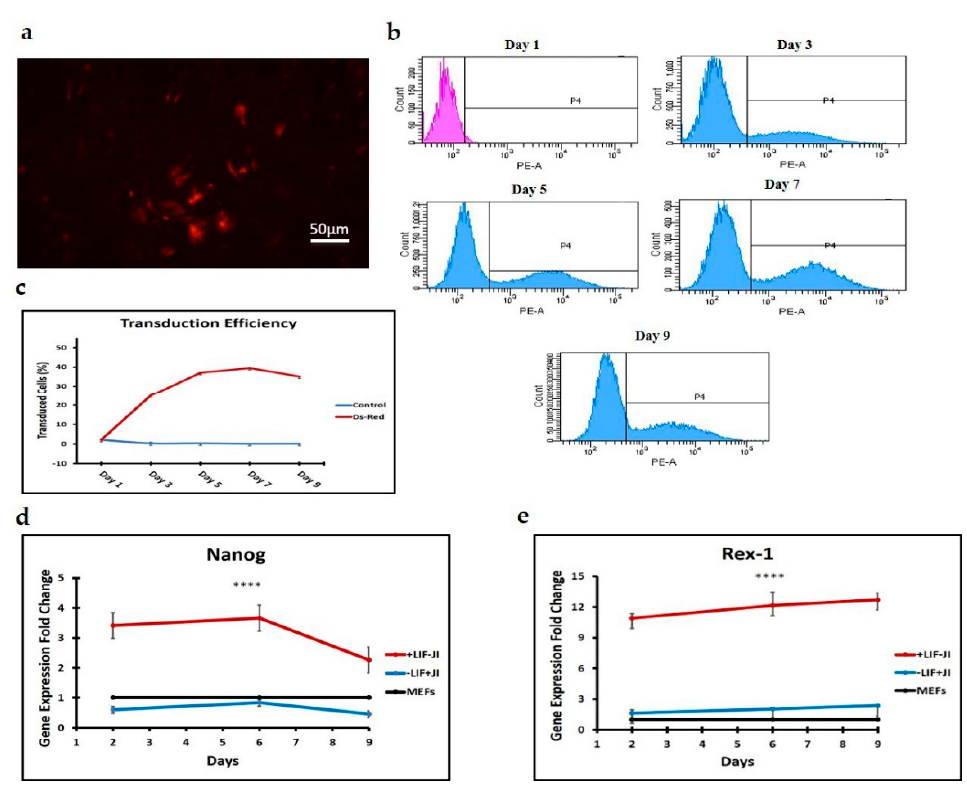
Figure 1. Transduction efficiency of MEFs using lentiviral vectors. To evaluate the efficiency of transduction, we utilized the fluorescence reporter gene Ds-Red and transduced MEFs as outlined in the materials and methods. ( a ) Transduced MEFs are fluorescent red under the microscope. Scale bar 50 μ m. ( b , c ) Transgene expression reached a maximum on day 7 and maintained the signal up to day 9. ( d , e ) Upregulation of pluripotency gene expression in the presence of iPSC-inductive media (+LIF/ − JI1), and trans-differentiation media ( − LIF/+JI1). Nanog and Rex-1 are significantly upregulated 3-fold and 10-fold, respectively, in cells under iPSC reprogramming media. **** p < 0.0001.